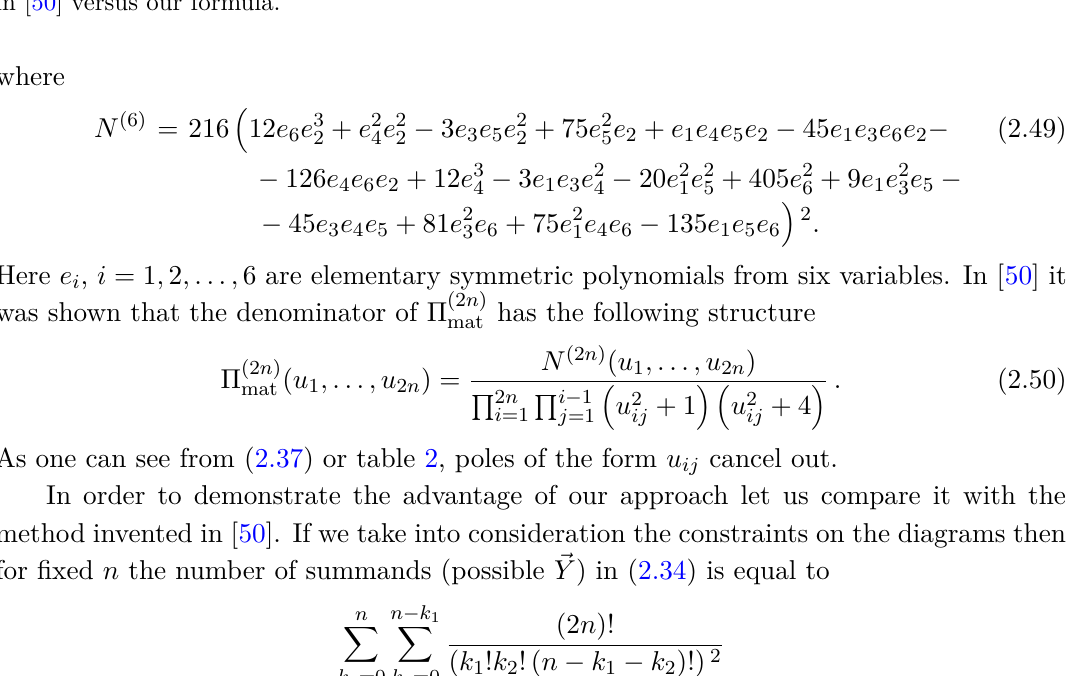
Table 3 . Comparison of the number of summands entering in the combinatorical expression given in [50] versus our